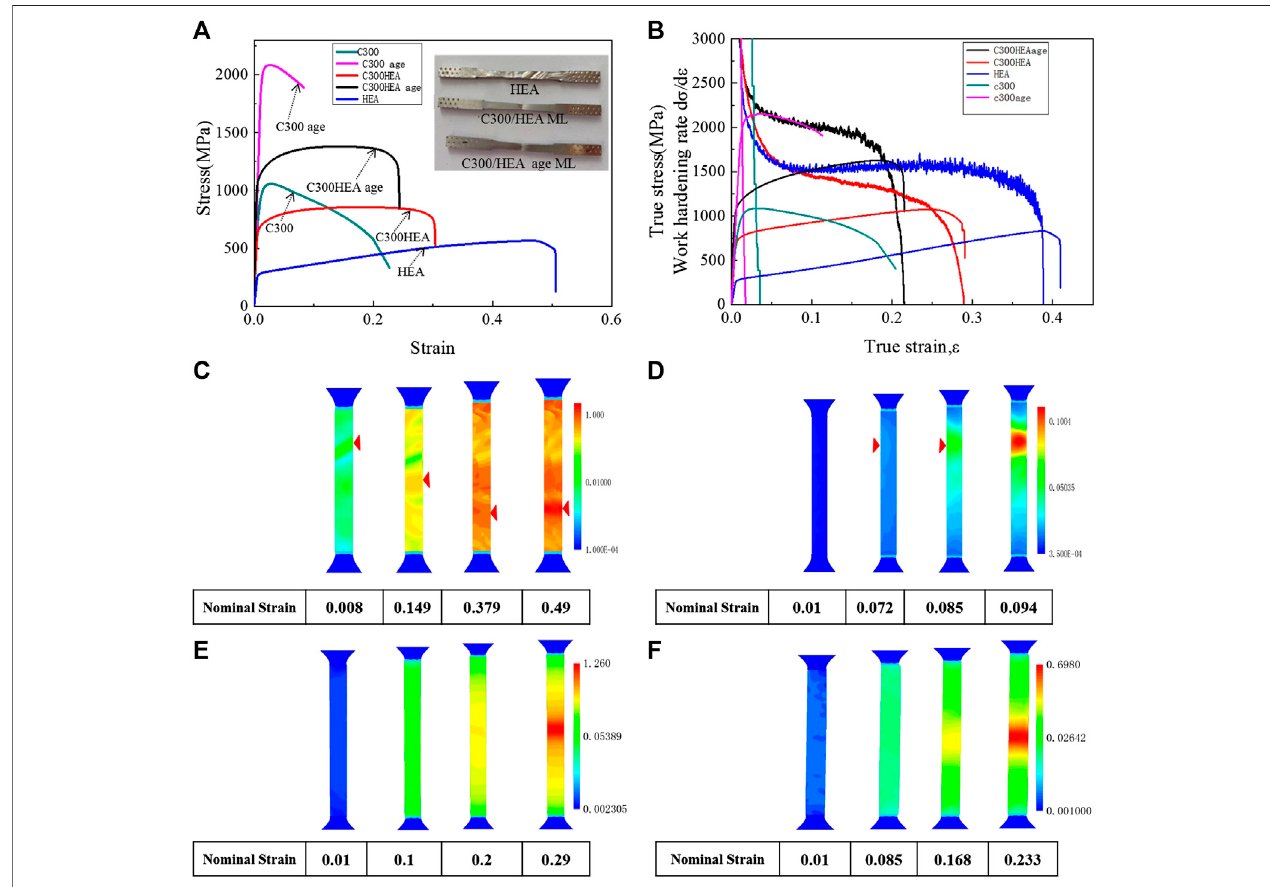
Table 2 . The calculated values are approximated to the experimental results.